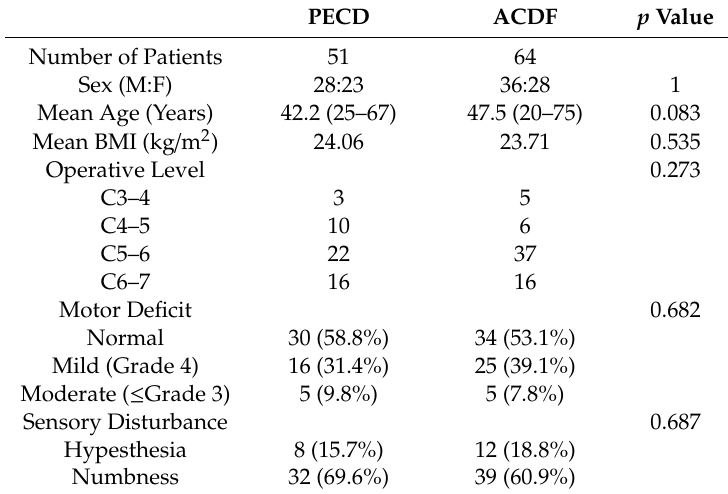
Table 1. Demographic characteristics.